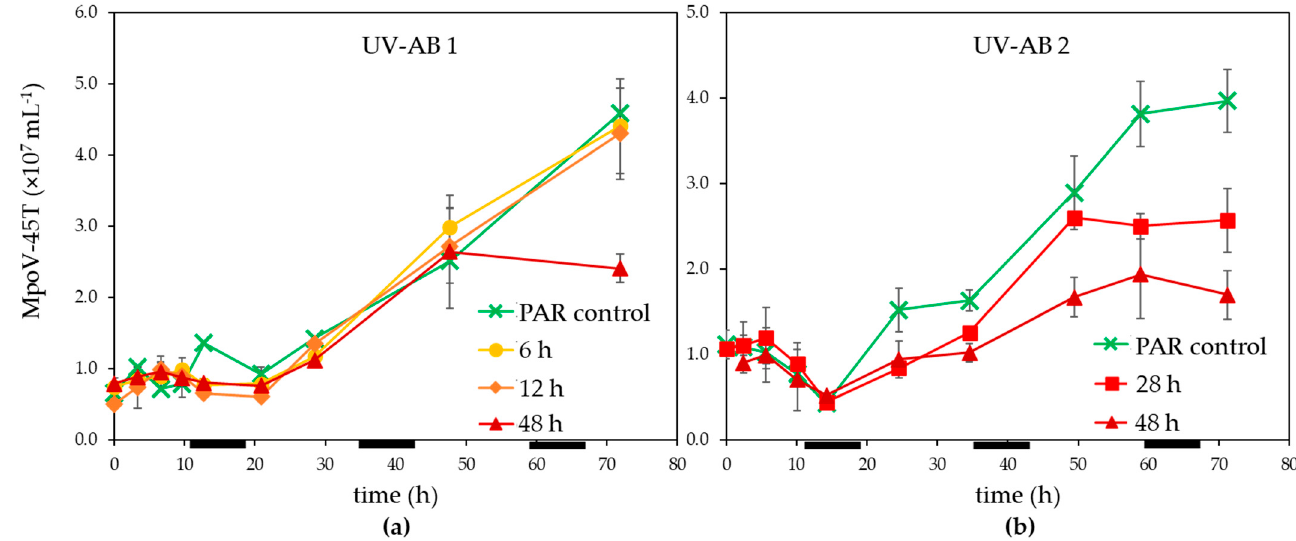
Figure 3. Temporal abundance of virus MpoV-45T under UV-AB exposure during ( a ) experiment 1 and ( b ) experiment 2. Average values with standard deviation ( n = 2 except for experiment 2 PAR-only control where n = 1). The horizontal black bars indicate the dark period.